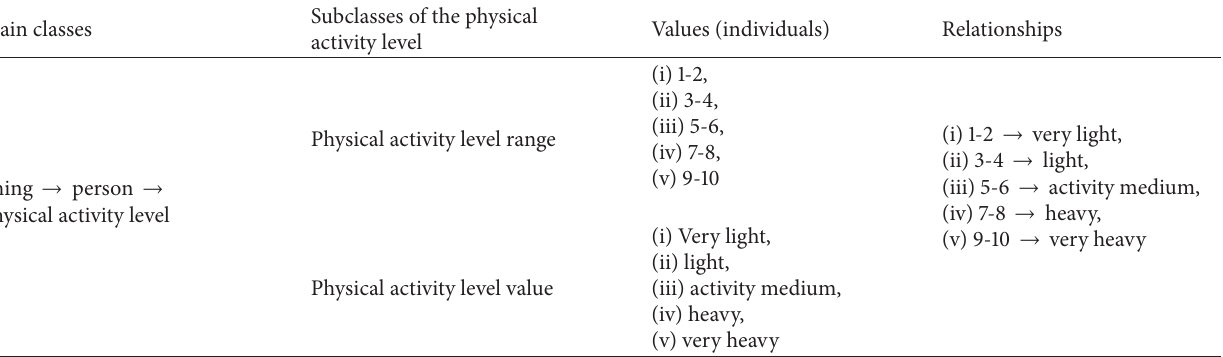
Table 2: Physical activity level class includes two subclasses: physical activity level range and physical activity level value, with their values for